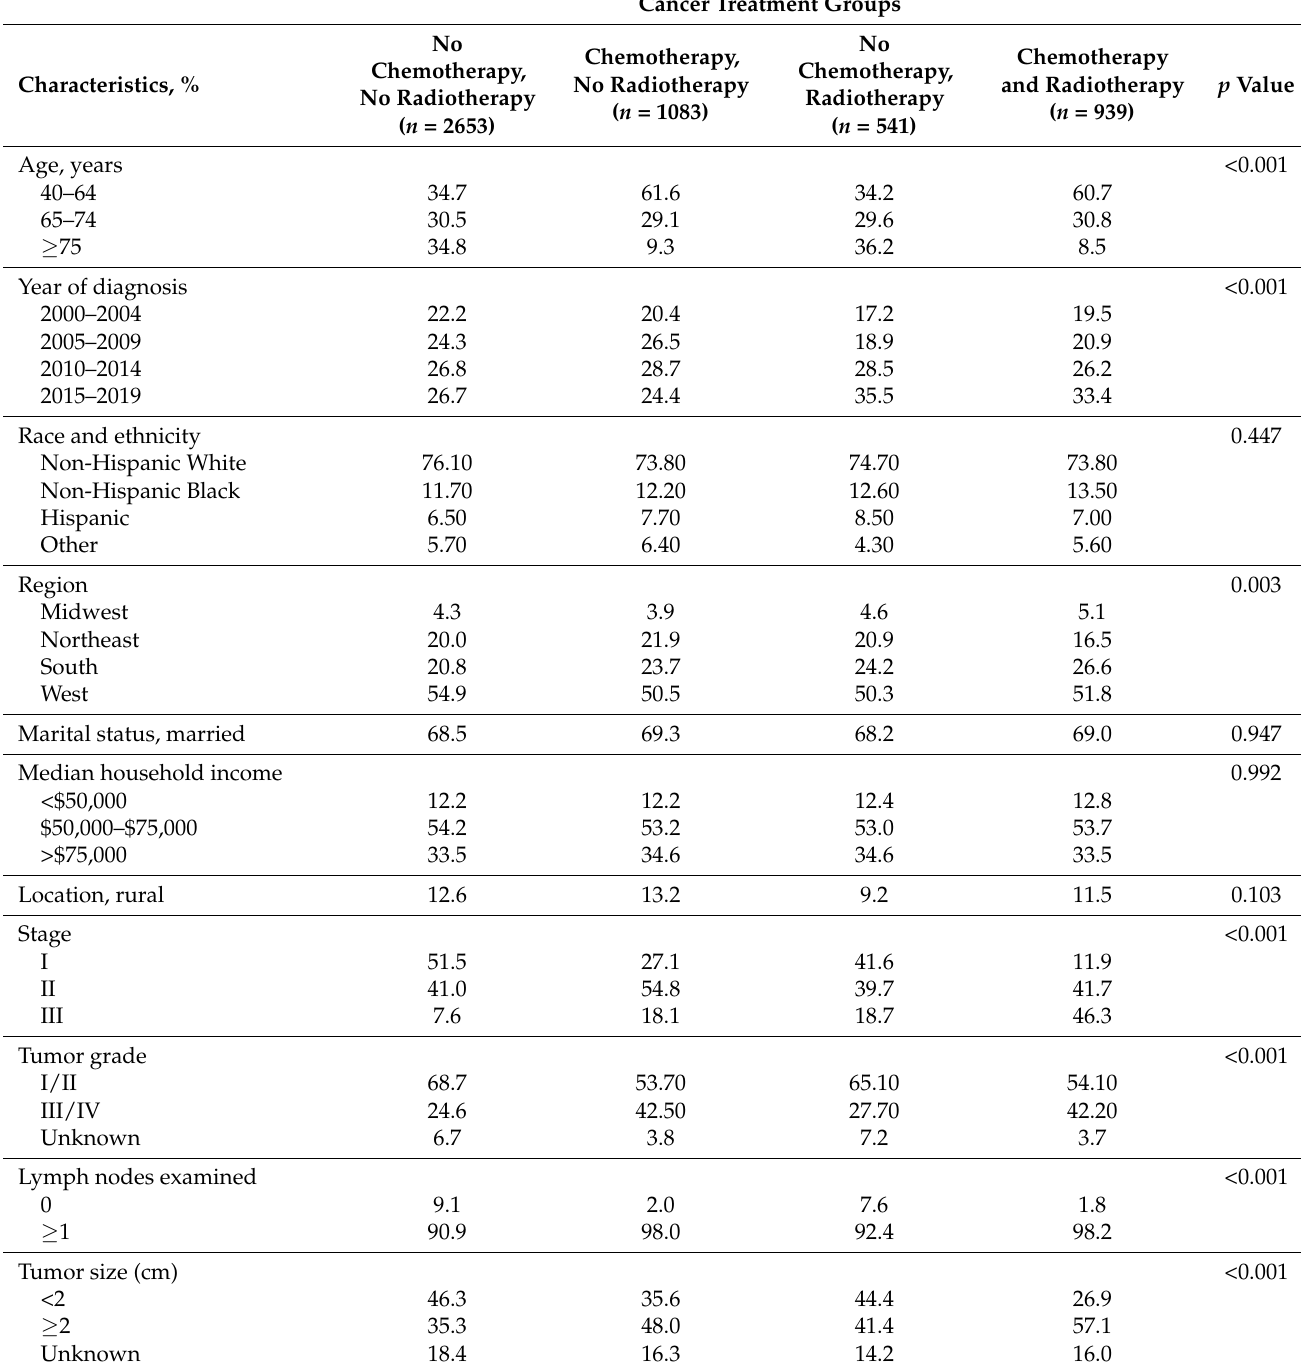
Table 1. Characteristics of men at the time of breast cancer diagnosis according to cancer therapy, SEER program ( n = 5216). Cancer Treatment